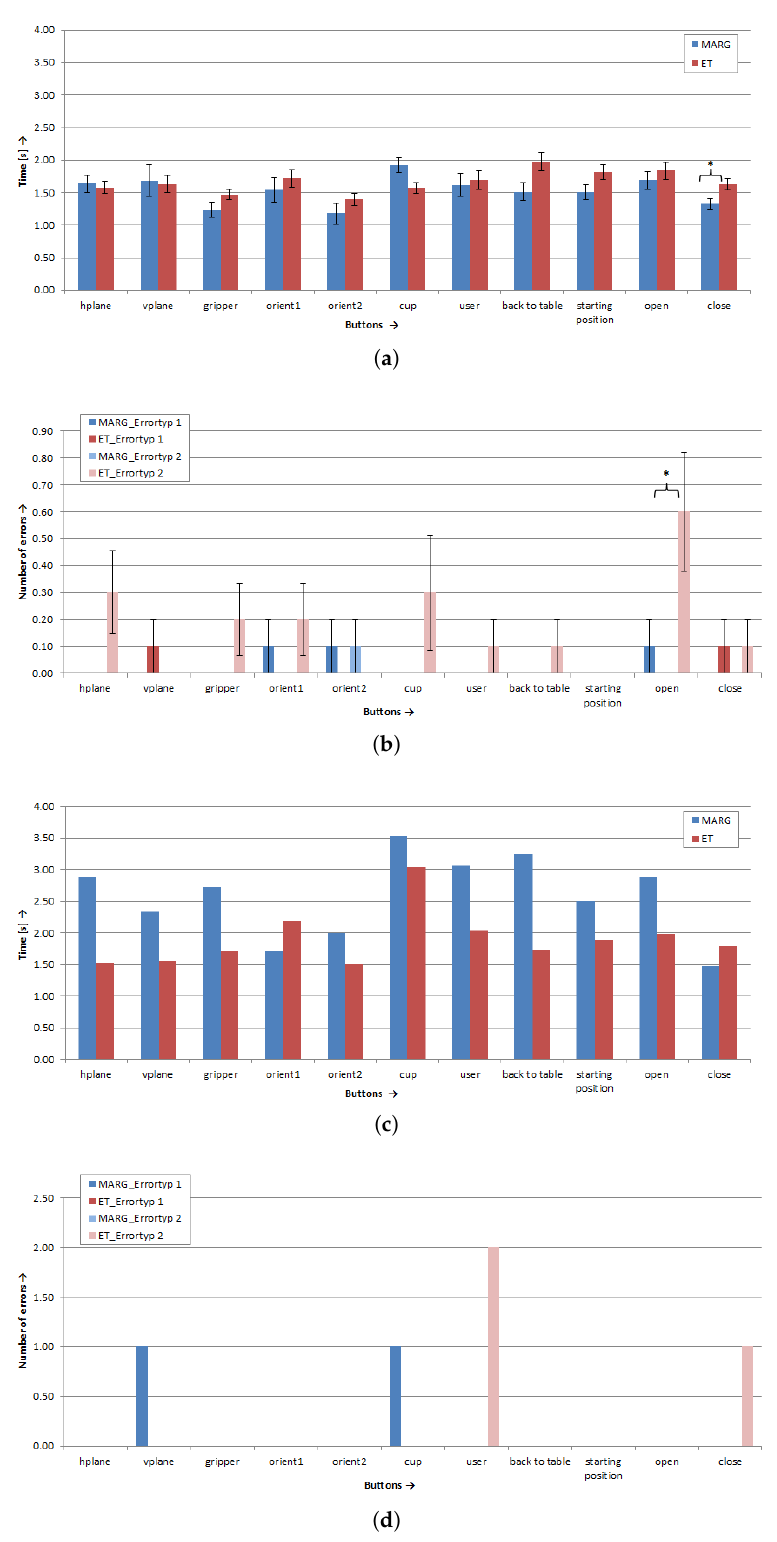
Figure 7. Results of test button activation for the eleven buttons: ( a ) Able-bodied subjects ( n = 10), mean value of activation time ± standard error (SE); ( b ) able-bodied subjects ( n = 10), mean value of number of errors ± SE; ( c ) subject with tetraplegia ( n = 1), activation time values; and ( d ) subject with tetraplegia ( n = 1), number of errors. * Marks sig. differences ( p <